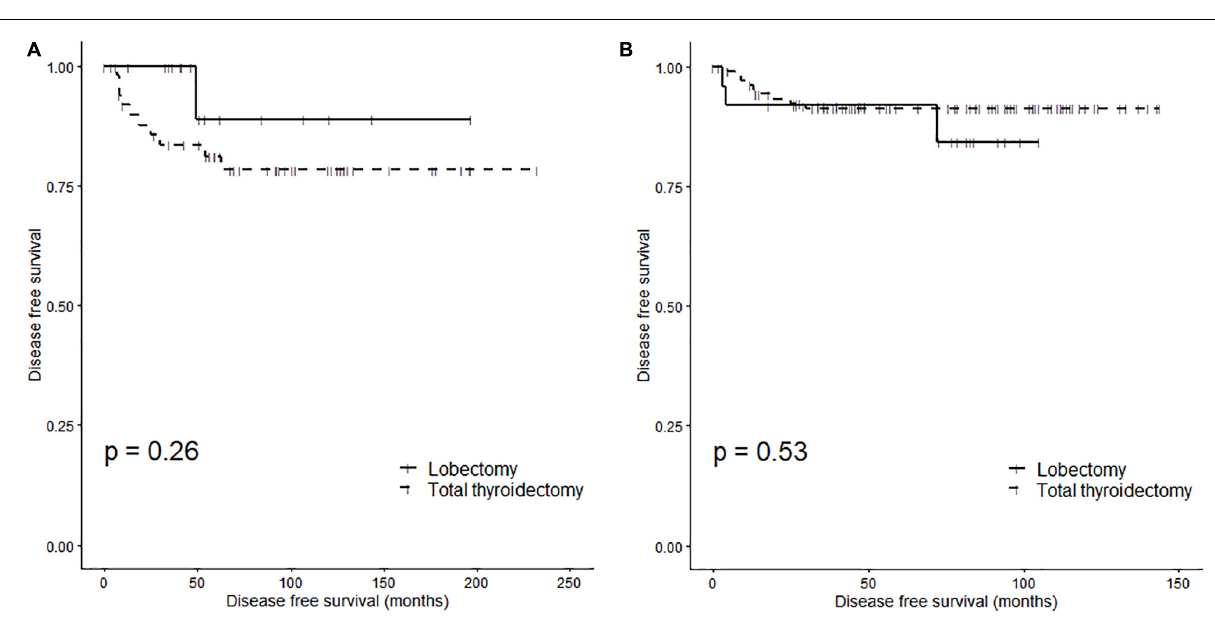
CI: 93.52%) and 91.46% (lower 95% CI: 86.75%, upper 95% CI: 96.42%) in pediatric and adult patients,